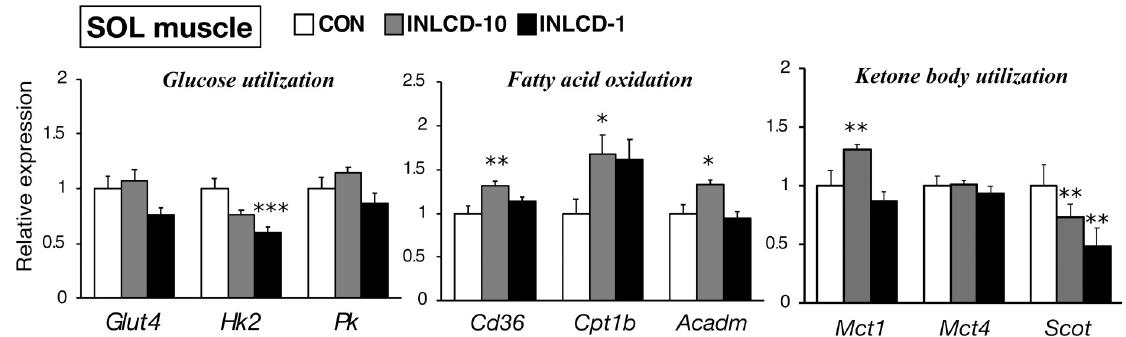
Fig 5. Effects of INLCD exposure on metabolic gene expression in SOL muscles of mice. Gene expression levels in the SOL muscles of mice fed the control diet (CON, open bar), those fed an INLCD-10% (INLCD-10, gray bar) and those fed an INLCD-1% (INLCD-1, black bar) groups are shown. The mRNA abundance was quantified and normalized to β -actin (n = 8 per group). Data shown are means ± SEM. Values are expressed as the fold-change compared with the CON group, which was arbitrarily set to 1. � , p < 0.05; �� , p < 0.01; ��� , p < 0.001 vs.